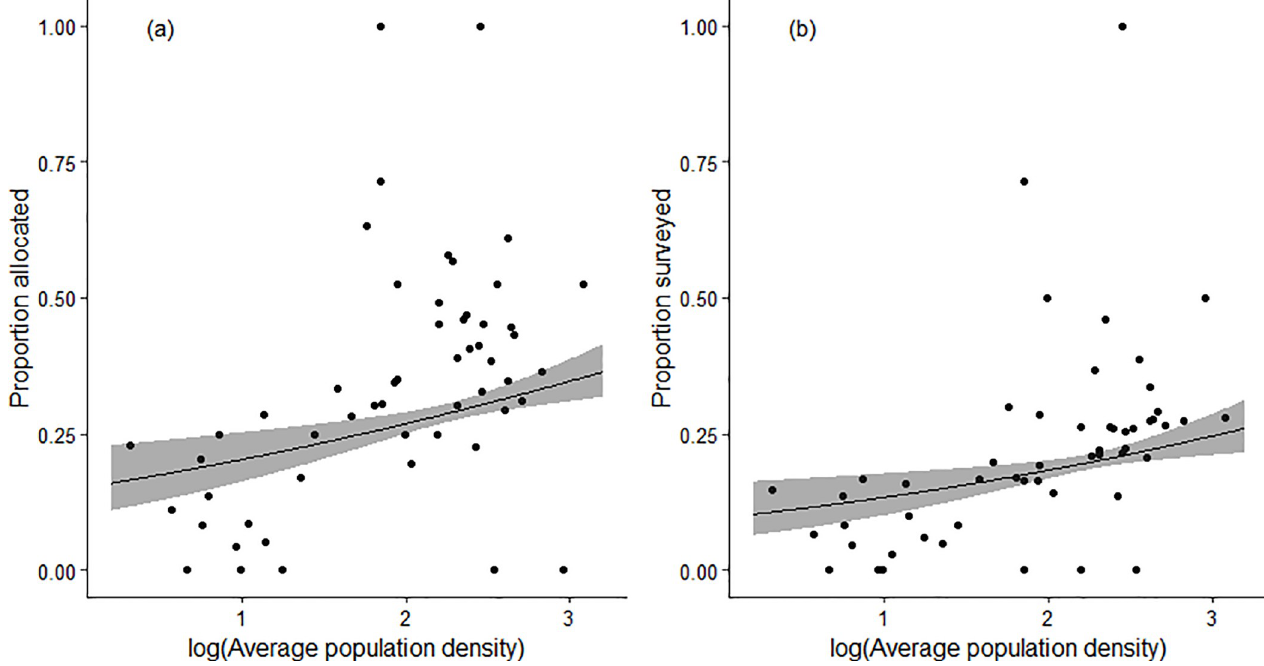
Fig 3. The relationships between monad allocation/survey status and population density. (a) The relationship between the proportion of allocated monads per 100 x 100 km region as a function of population density; (b) The relationship between the proportion of surveyed monads per 100 x 100 km region as a function of population density. Grey ribbons represent 95% confidence